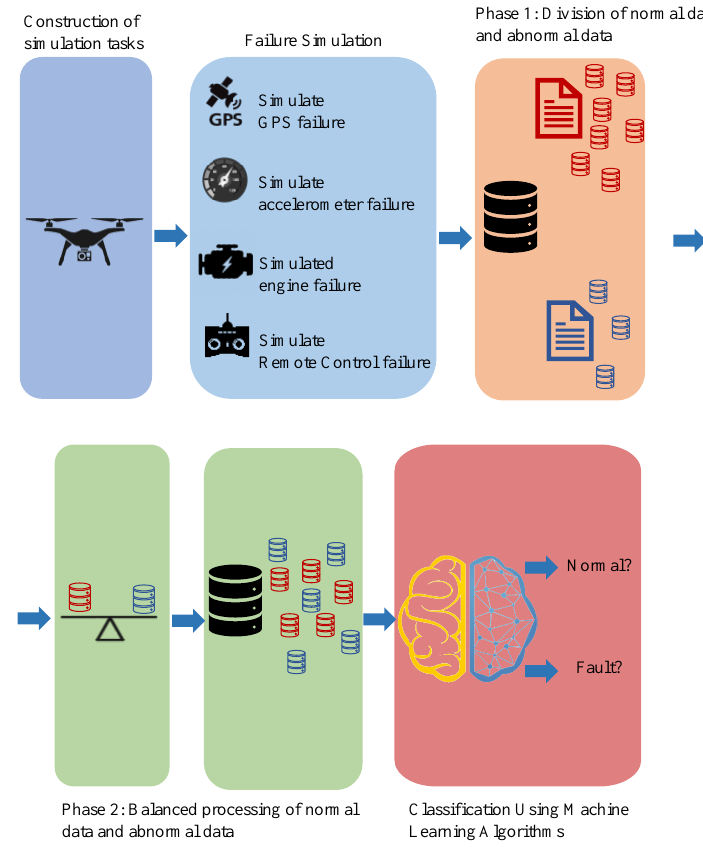
Phase 2: Balanced processing of normal data and abnormal data Figure 2. Flowchart of the TLM